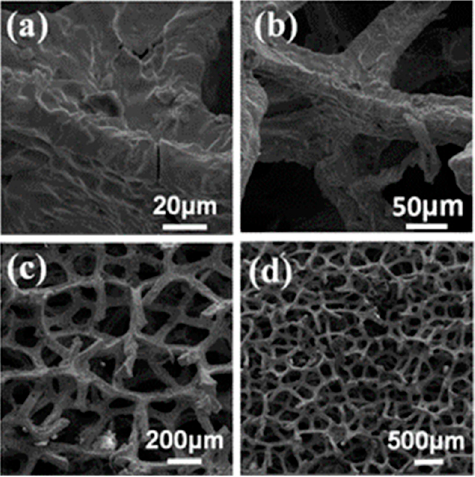
Figure 3. SEM images showing phase structure and morphology of GM1 foam at di ff erent magnification levels: ( a ) 20, ( b ) 50, ( c ) 200, and ( d ) 500 µm.